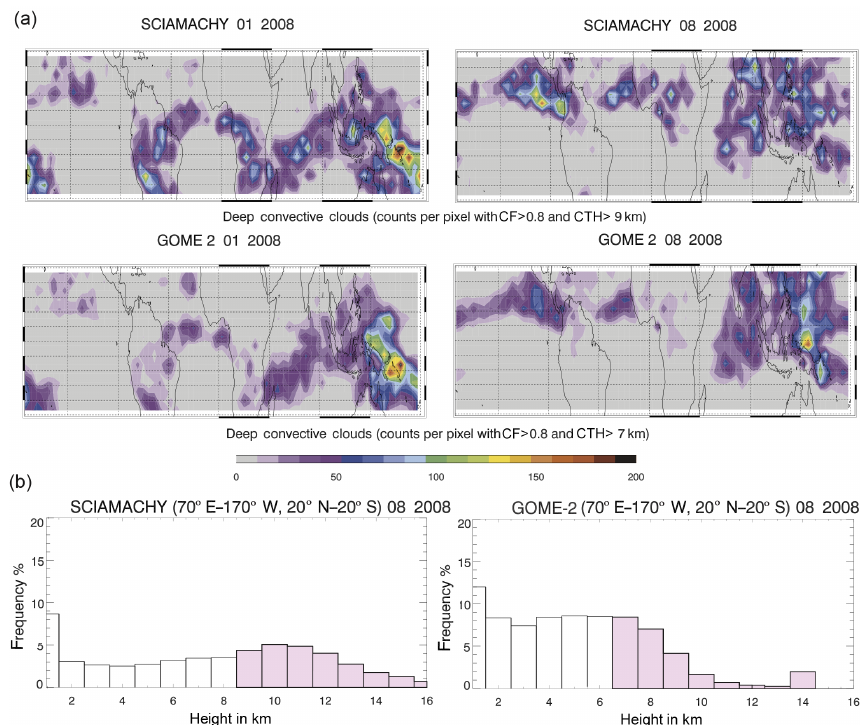
Figure 3. (a) The number of counts per grid box with CF greater than 0.8 and CTH greater than 9km (SCIAMACHY) and CTH greater than 7km (GOME-2) for January and August 2008. (b) Frequency of cloud-top heights (CTH) for August 2008 from SCIAMACHY (SACURA) and GOME-2 (FRESCO) in the western Pacific area (20 ◦ S–20 ◦ N, 70 ◦ E–170 ◦ W). Pink shaded data are used for the ACCO